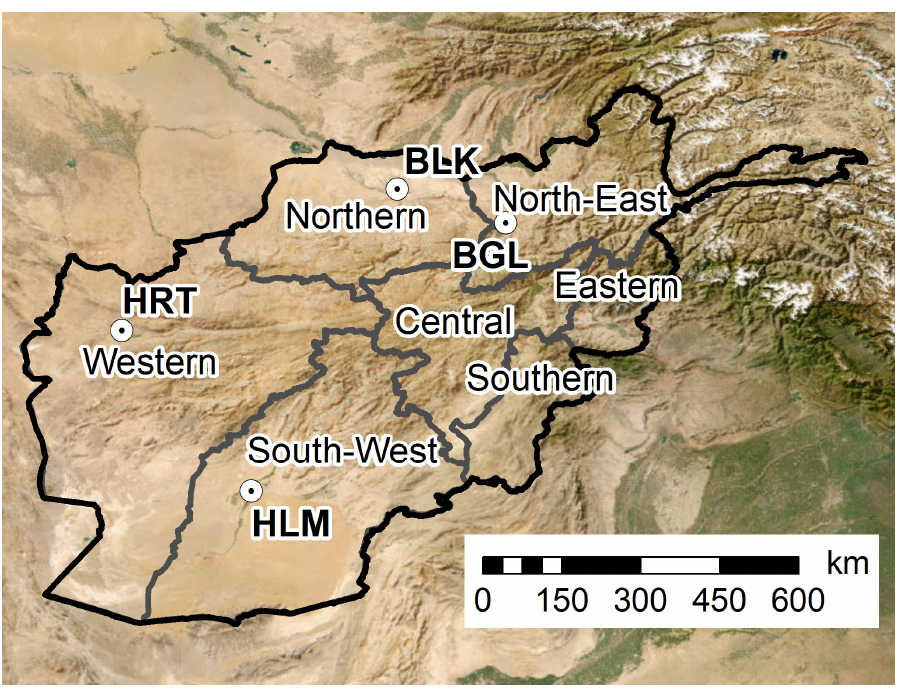
Figure 1. Map of the agro-climatic zones of Afghanistan with the four study sites: Baghlan (BGL), Balkh (BLK), Helmand (HLM), and Herat (HRT).